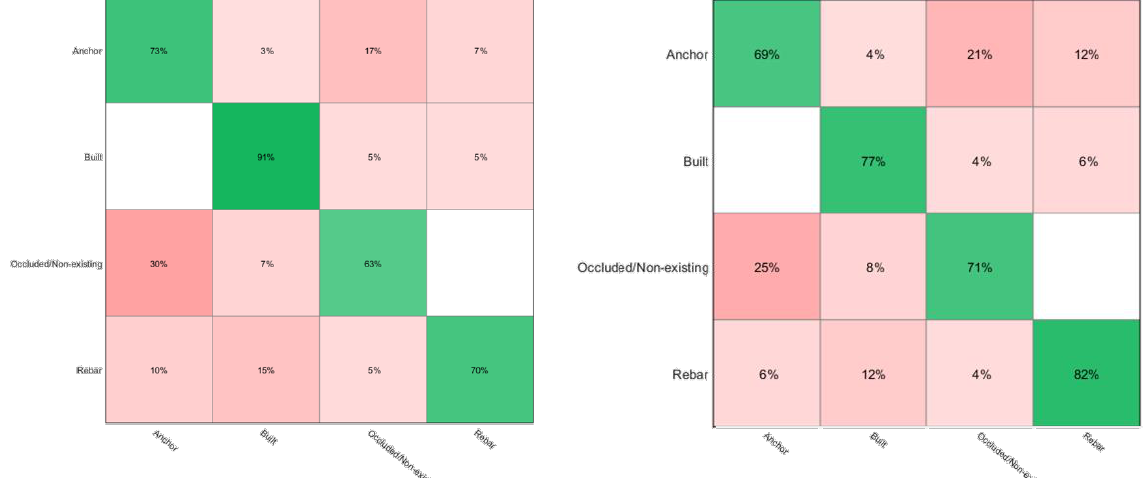
Figure 4b: Cross-validation confusion matrices of the prototype Random Forests model on the progress monitoring data set. The left hand labels are the true classes while the bottom labels are the predicted classes.